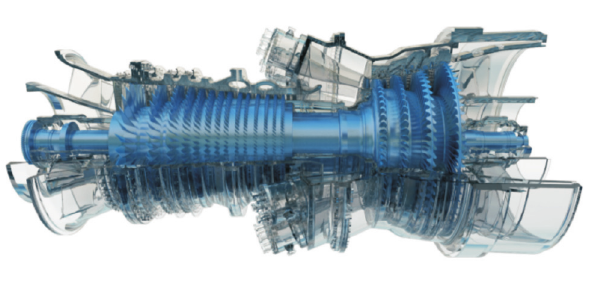
Fig. 5. GE 9Ha.2 gas turbine [11]